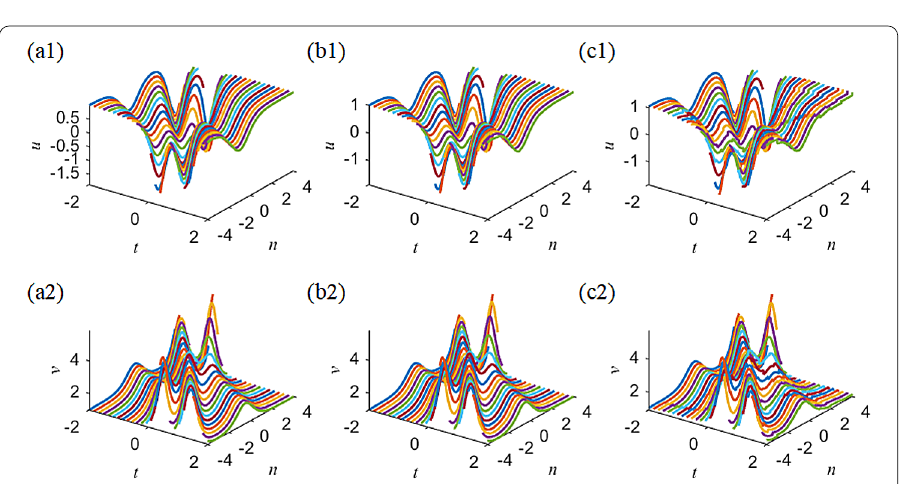
Figure 7 Three-soliton solution (45) with the same parameters as Fig. 4. ( a ) Exact solution; ( b ) Time evolution using exact solution (45) as an initial condition; ( c ) Time evolution using exact solution (45) perturbed by a 5% noise as the initial